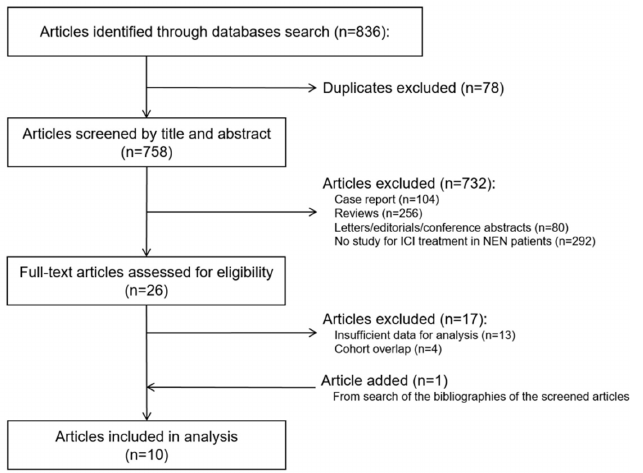
Figure 1. Flow diagram of the study selection. ICI, immune checkpoint inhibitors; NEN, neuroen- docrine